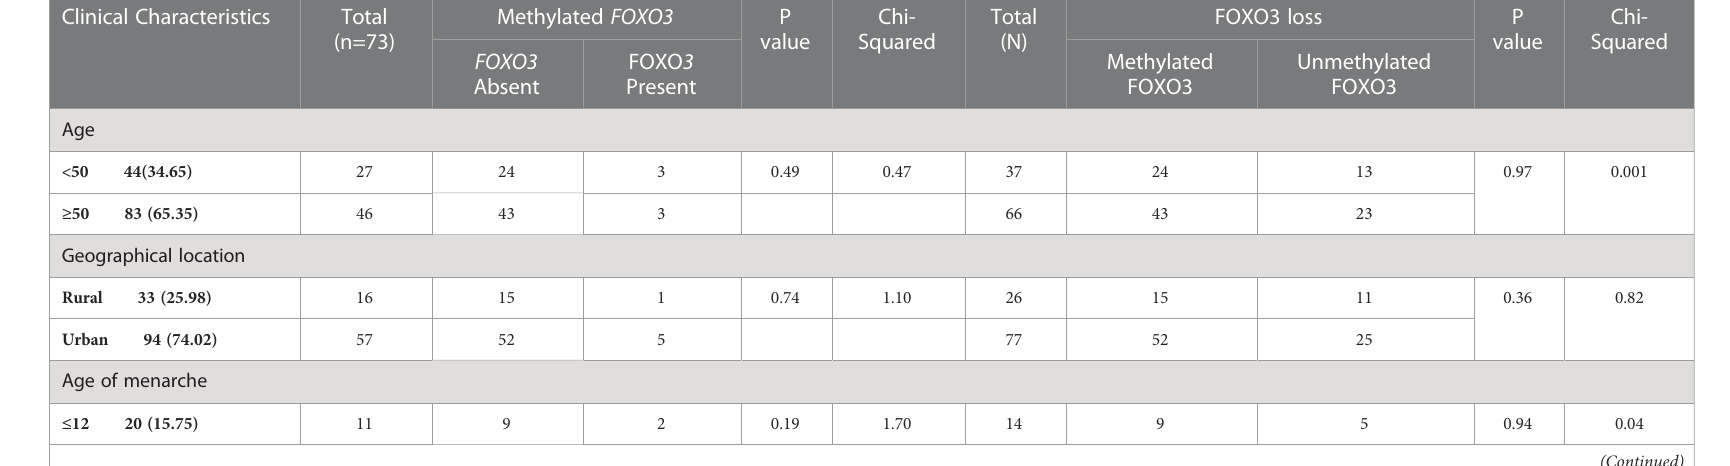
TABLE 6 Correlation study of methylation and protein expression in samples having methylated FOXO3 promoter or FOXO3 expression loss with clinical parameters of Breast cancer patients from North Indian